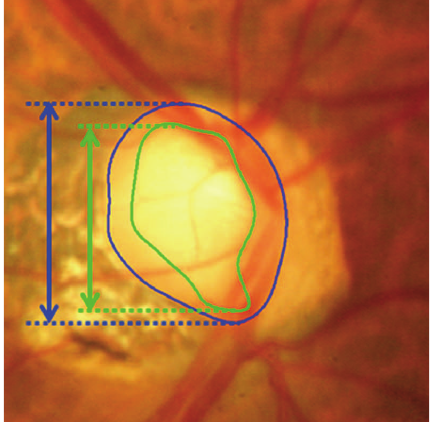
Figure 4: Measurement of cup-to-disc ratio for a tilted disc [44].